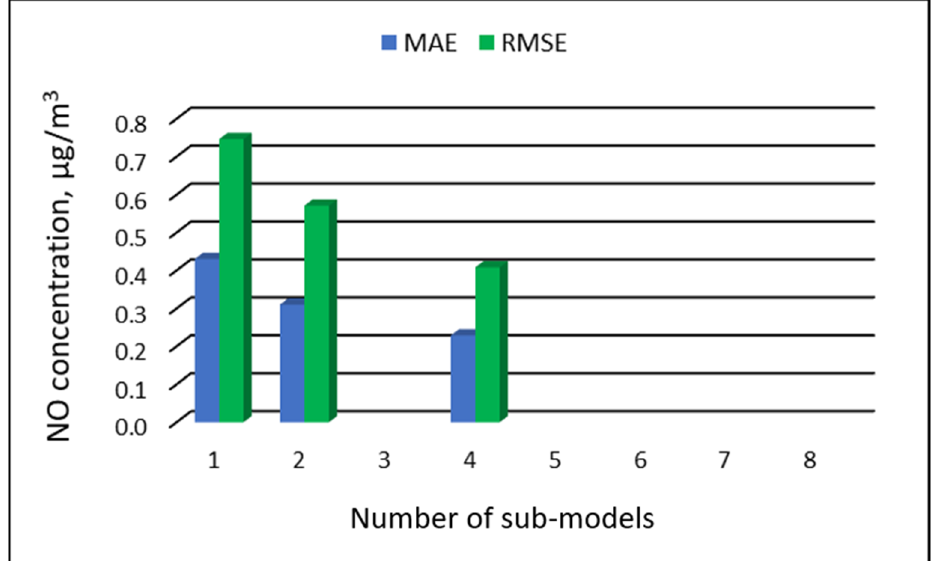
Figure 12. Overall MAE and RMSE values for NO concentration prediction in RVS models depend- ing on the number of created sub-models, Z ł oty